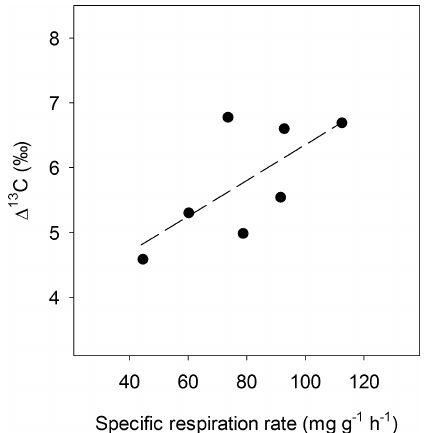
Figure 6. Correlation between the specific respiration rate (in mgC per g microbial biomass C and hour) of P. fluorescens growing in continuous chemostat culture at temperatures ranging from 13 to 26.5 ◦ C and the carbon isotope discrimination during respi- ration. The dashed line denotes a linear regression of the form y = 0.03 ×+ 3.6; R 2 = 0.48; P =